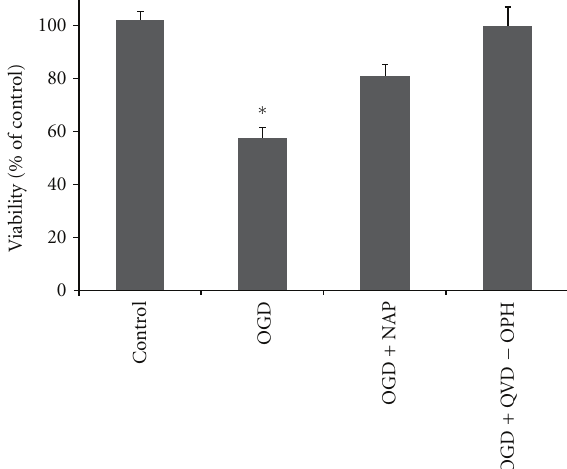
Figure 3: Following 2 hours of OGD, cells died exclusively from apoptosis. Cultures were treated with either NAP (10 − 5 M) or QVD- OPH (2 ∗ 10 − 5 M) and subjected to 2h of ischemic insult. Cell viability was evaluated immediately following the ischemic period using MTS viability assay. Data was normalized to % of control. Results are shown as mean ± SE; ∗ significantly di ff erent from all other groups, P ≤ 0 . 05 (ANOVA, with post hoc Sche ff